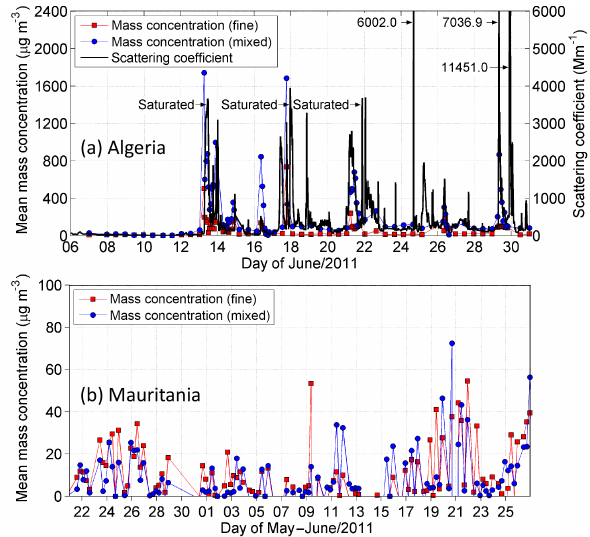
Figure 3. Mass concentration in µgm − 3 and scattering coefficient in Mm − 1 of dust in (a) Algeria and (b) Mauritania. For the mass concentration, each data point represents the average for the given sampling period. Fine-mode mass concentration is calculated from the second-stage filters. Mixed mass concentration is calculated from the first-stage filters, where both fine and coarse particles ad- here to the surface. Note the different scales on the y axis in panels (a) and (b) . Uncertainties were estimated to vary between 3.0 and 7.0µgm − 3 for days with low and high mass concentrations, respec- tively. The integrated scattering coefficient was measured at 670nm at SS1 in Algeria only in the period of 6–30 June 2011. Before 22 June events of dust that had its scattering coefficient exceeding 3500Mm − 1 saturated the equipment, as marked in the plot. Un- certainties of the scattering coefficient were estimated to be within